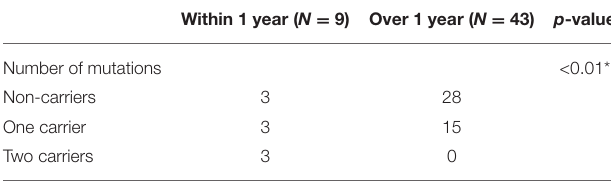
TABLE 6 | The genetic characteristics of patients with ALS at childbearing age.